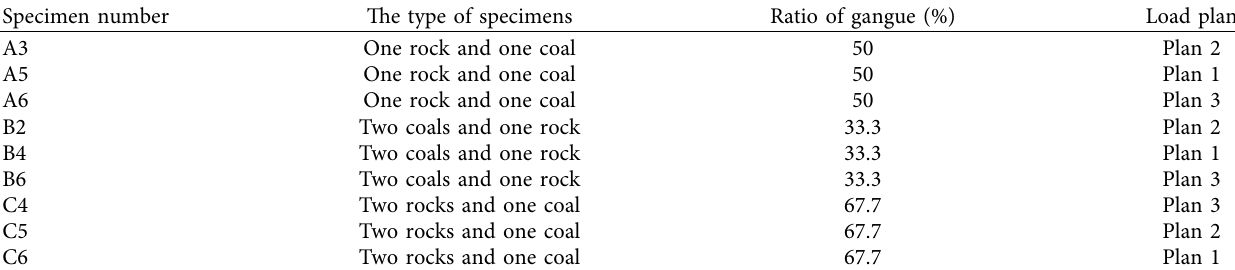
Table 1: Specimens and the according load